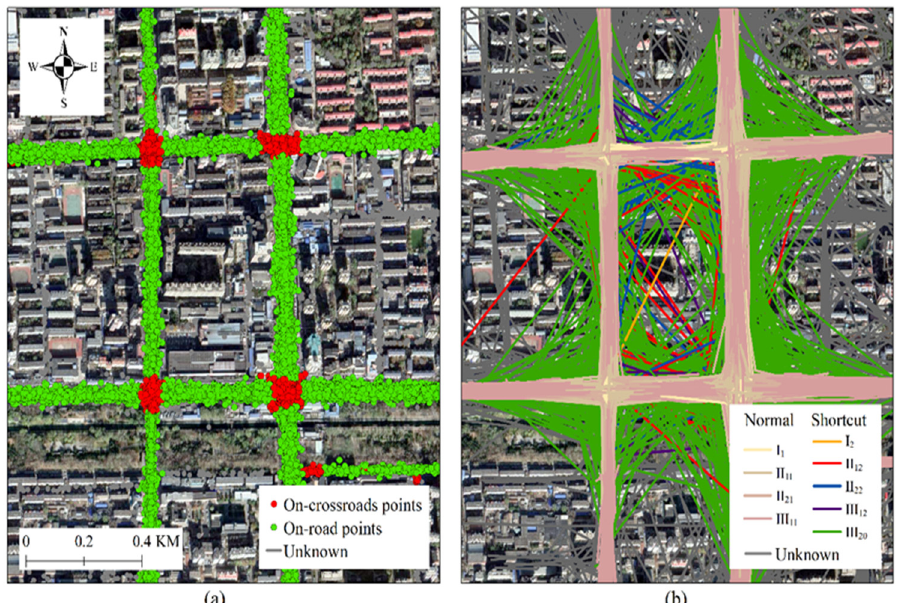
Figure 7. High-quality tracking points versus poor-quality tracking links at the Mudanyuan site: ( a ) shows that on-crossroads and on-road tracking points are well separated in space and ( b ) shows the complex intercross pattern of poor-quality tracking links at the intersection area.